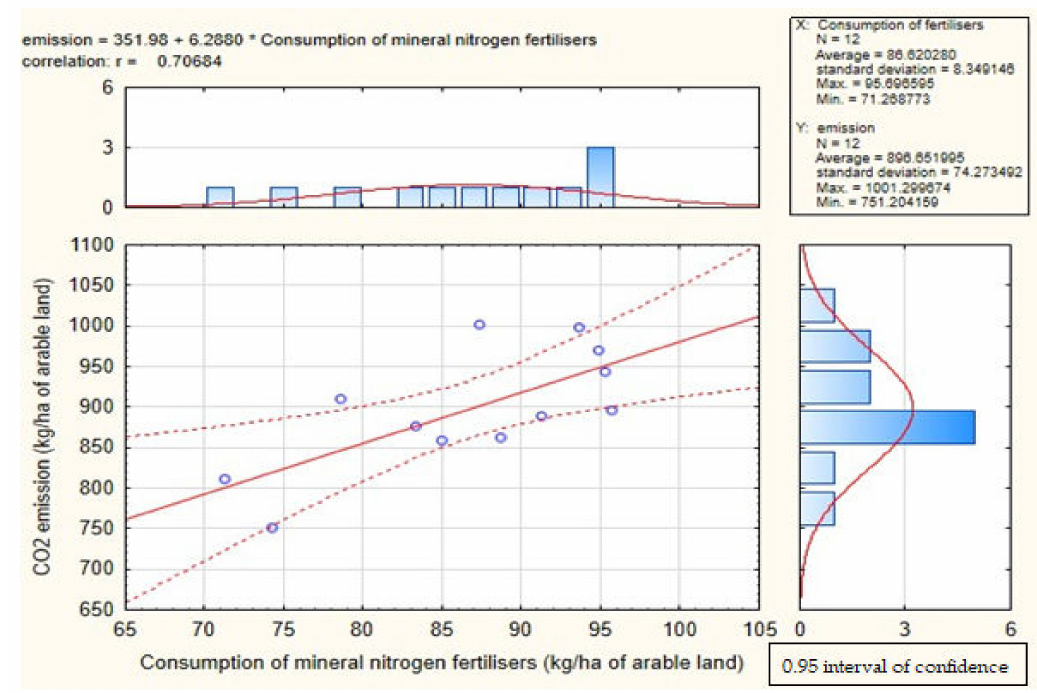
Figure A6. Results of correlations analysis: Slovakia. Source: own calculation based on Eurostat. Note: purple dot: observation, red solid line: linear function, red dashed lines: 95% interval of confidence.